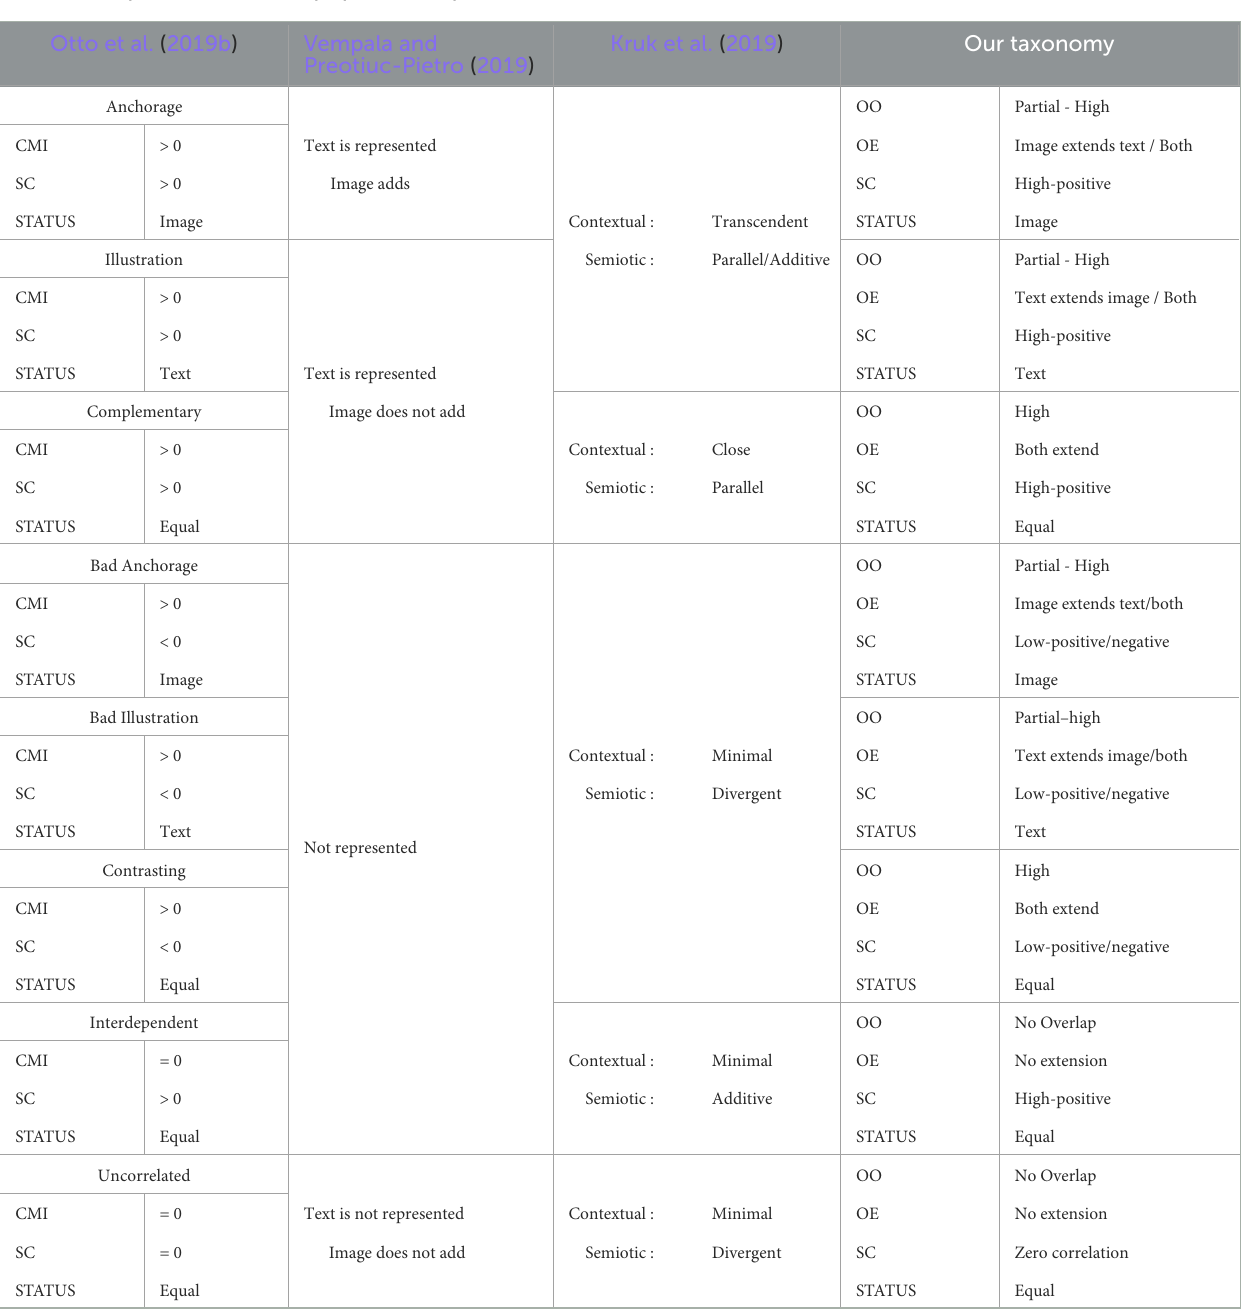
TABLE 1 A comparison of taxonomies proposed in computational sciences to build multimodal models. Otto et al.